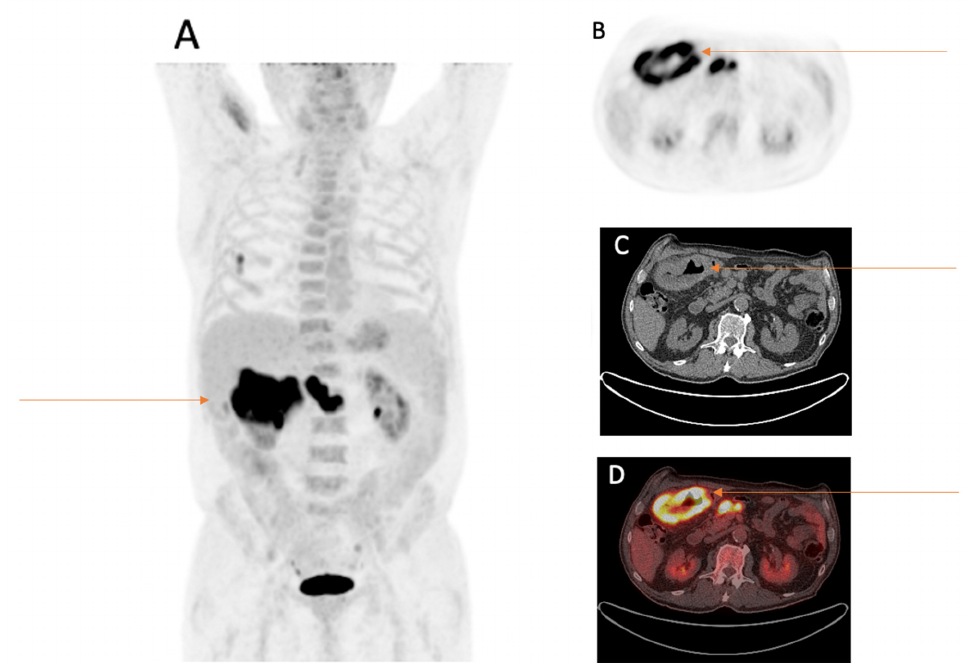
Figure 3. Eighty-three-year-old male patient with first diagnosis of NSCLC (TTF1 positive adenocar- cinoma of the right lower lobe pT1b, pN0, M0) underwent FDG-PET/CT for staging. FDG-PET/CT scan displayed an incidental FDG-avid wall thickening of the right colon flexure with three FDG-avid locoregional lymph nodes. ( A ) MIP image after the intravenous injection of 322 MBq 18 F-FDG. ( B ) PET image of the right colon flexure. ( C ) CT image of the right colon flexure. ( D ) Fused PET/CT image of the right colon flexure. After further investigations, the wall thickening was histopathologically con- firmed as microsatellite stable adenocarcinoma of the colon ascendens pT3 N2a (4/26), V1, L1, R0.